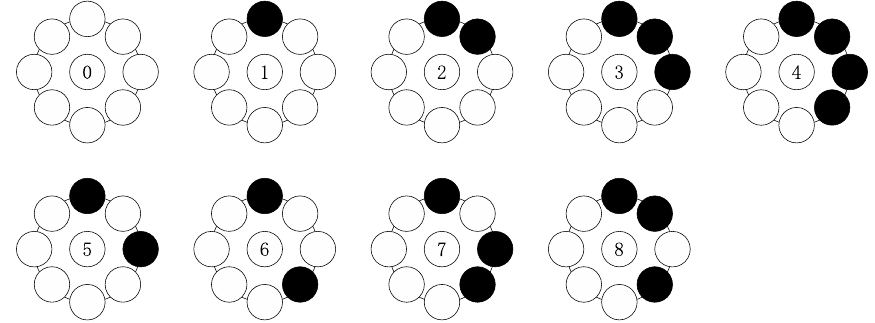
Figure 3. The nine rotation invariant patterns of the